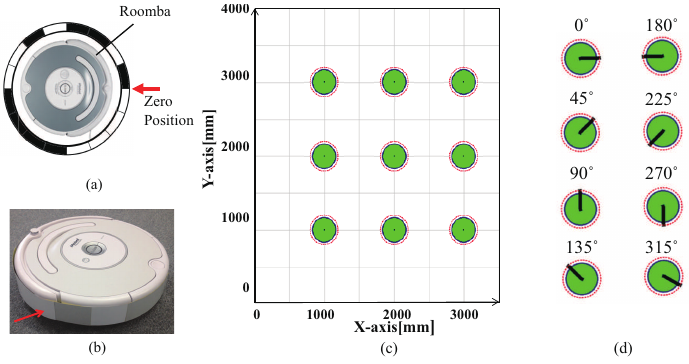
Figure 12. Evaluation of pose error: ( a ) reflection encoded tape, ( b ) target location, ( c ) evaluation of position error (x, y axis), ( d ) evaluation of direction error ( θ ).